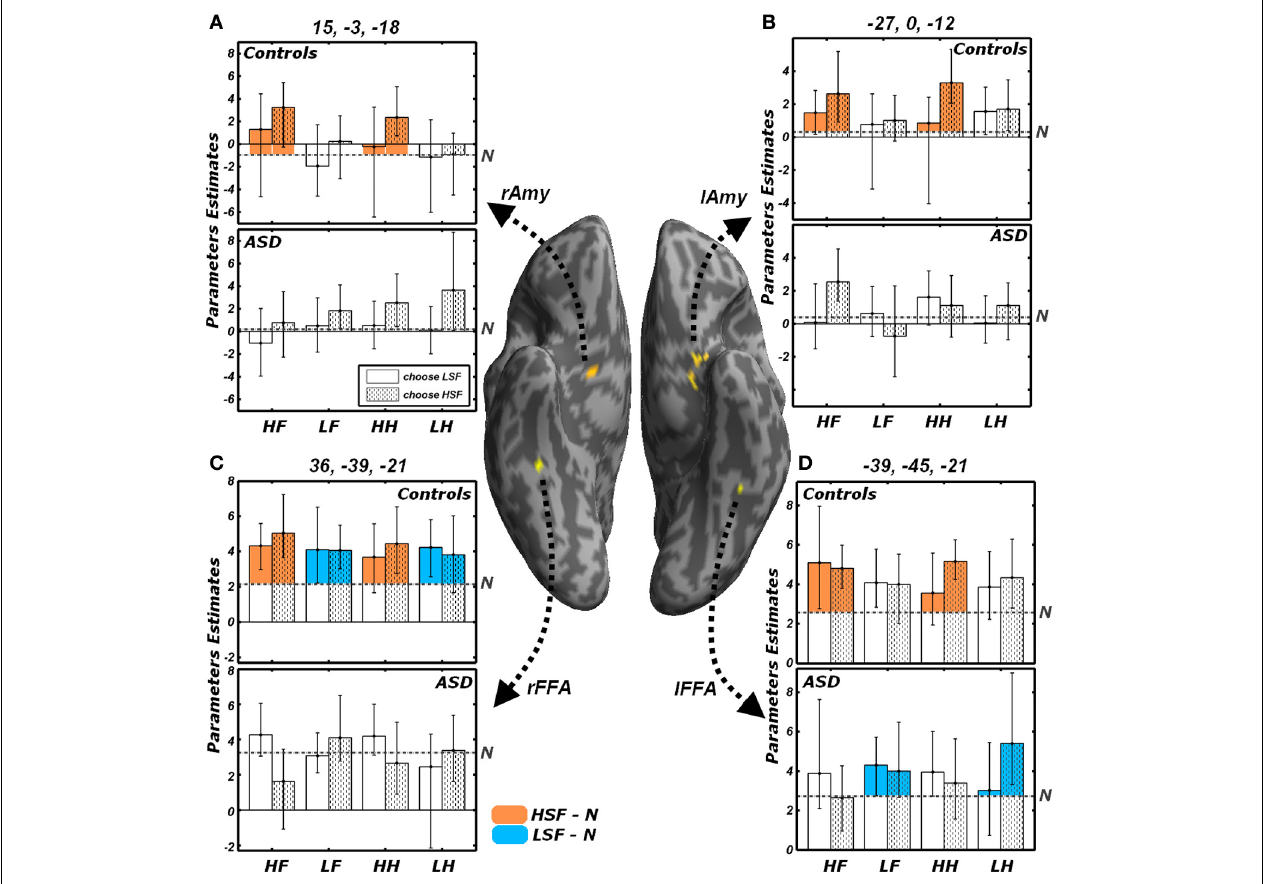
FIGURE 7 | Effects of the reported gender and of emotional valence. Average parameters extracted from representative voxels of (A) right Amygdala, (B) left Amygdala, (C) right FFA and (D) left FFA. The left and right FFA voxels were chosen as exhibiting significant conjoint activity for the contrasts LSF − N (as shown in Figure 5A ) and HSF − N ( Figure 5B ). Amygdalar voxels were those composing the clusters depicted in Figure 5B . The four regions are displayed in yellow on a ventral portion of an inflated human brain. For each of these four regions, average parameters estimates are displayed with bootstrap-based 95% confidence intervals of the mean. Data from different groups are displayed in separate subplots. Empty bars refer to trials in which participants choose the gender depicted